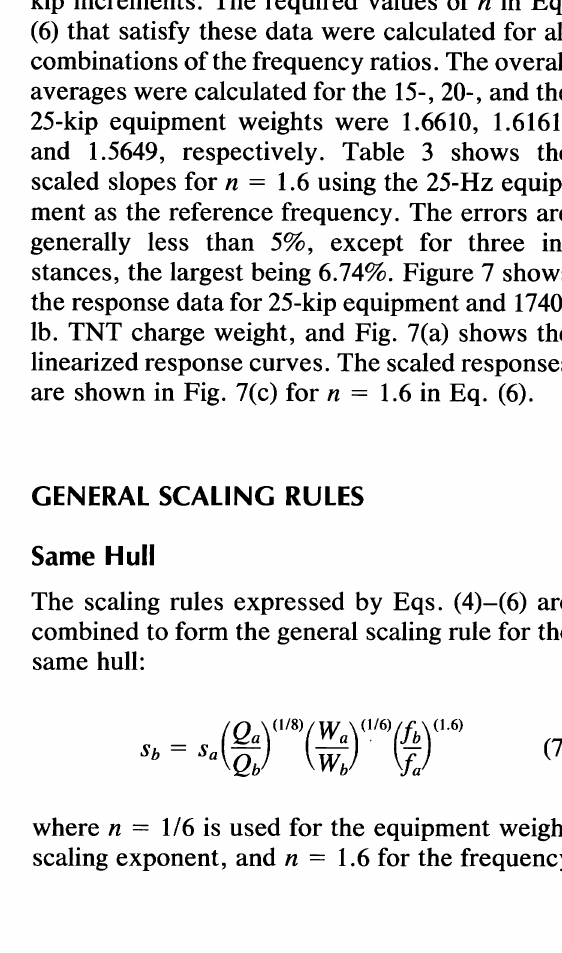
Table III Scaled Slopes for Model B Scaled on 25 Hz Using n